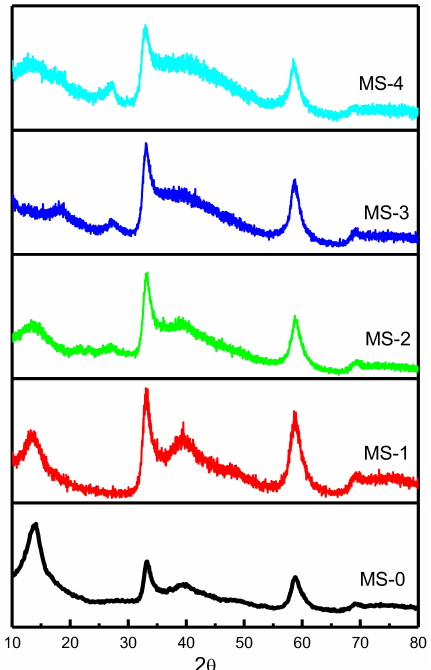
Figure 1. XRD of pure MoS 2 (MS-0) and MoS2-G (MS-1, MS-2, MS-3, and